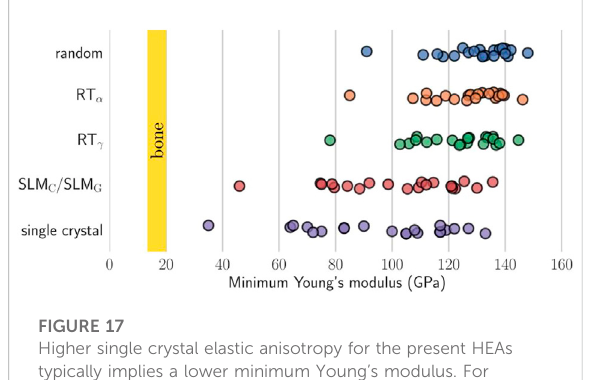
FIGURE 17 Higher single crystal elastic anisotropy for the present HEAs typically implies a lower minimum Young ’ s modulus. For comparison, the vertical yellow bars indicate the targeted Young ’ s modulus of cortical bone (Schönecker et al.,